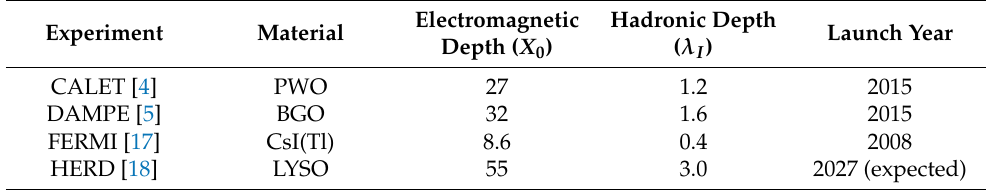
Table 1. List of space cosmic-ray experiments based on calorimetric instruments produced with inorganic scintillators, and the main characteristics of the